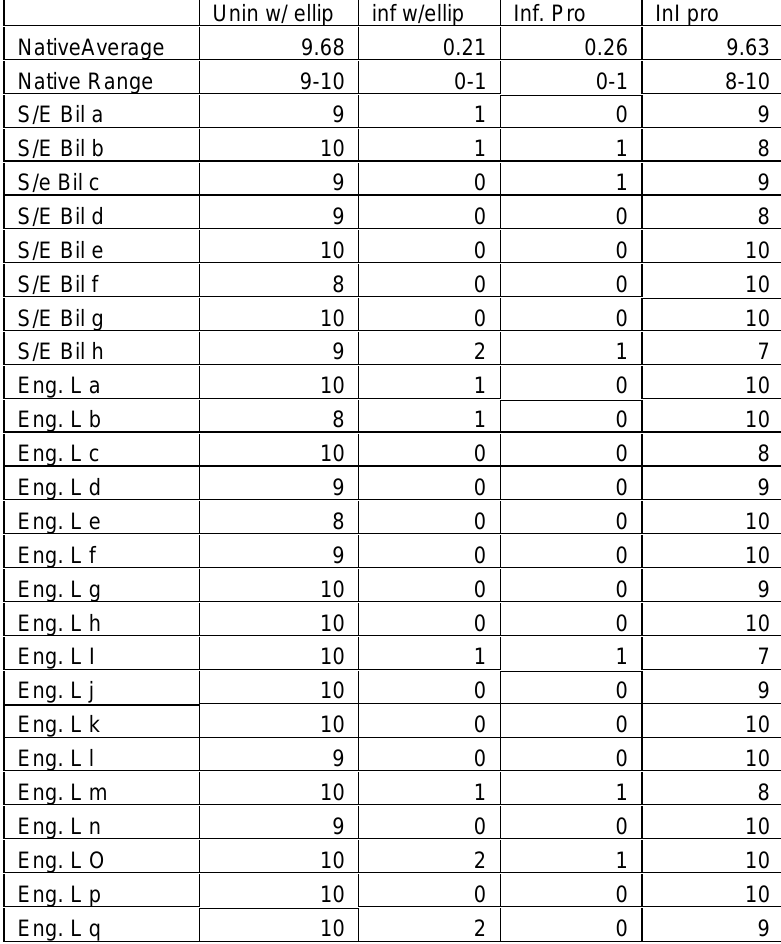
Table II: Individual Results from Task